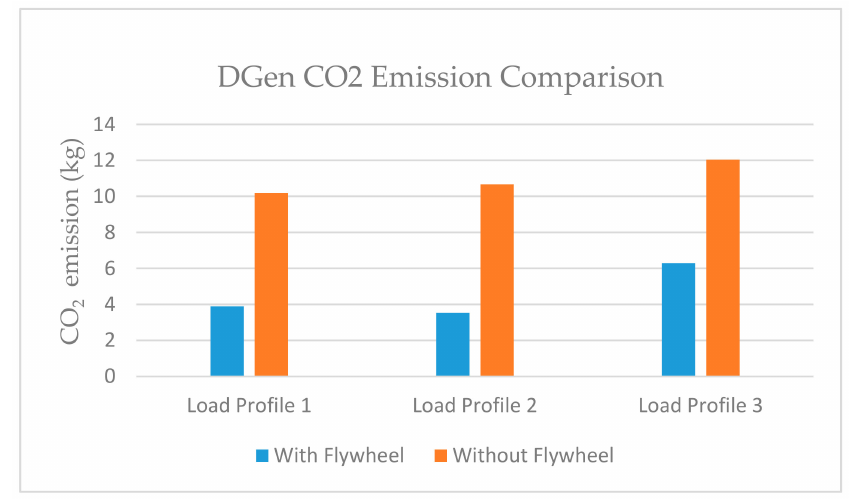
Figure 33. DGen emission comparison with and without